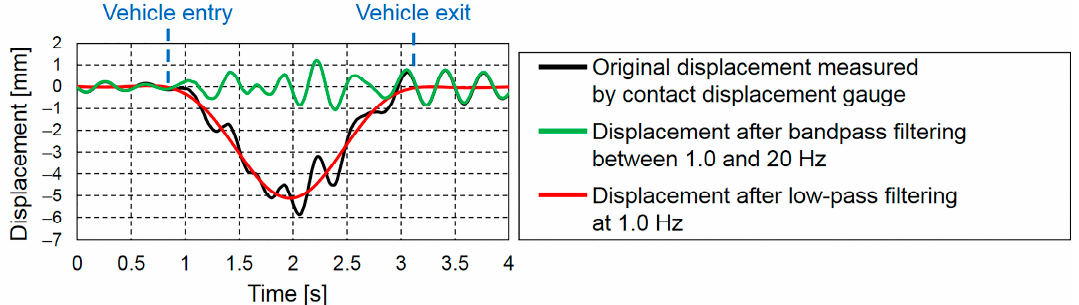
Figure 8. Filtered displacements obtained by separately applying a low-pass filter of 1.0 Hz and a bandpass filter between 1.0 and 20 Hz. a bandpass filter between 1.0 and 20